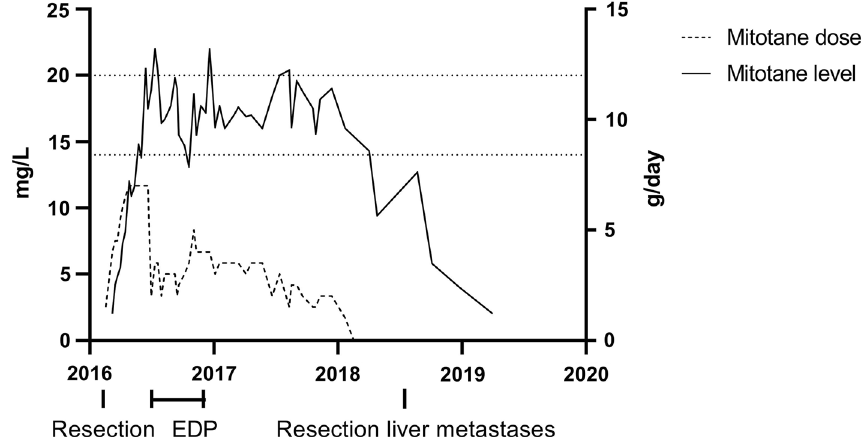
Fig. 1 Timeline with treat- ments, mitotane level (mg/L) and mitotane dose (g/ day). EDP etoposide,